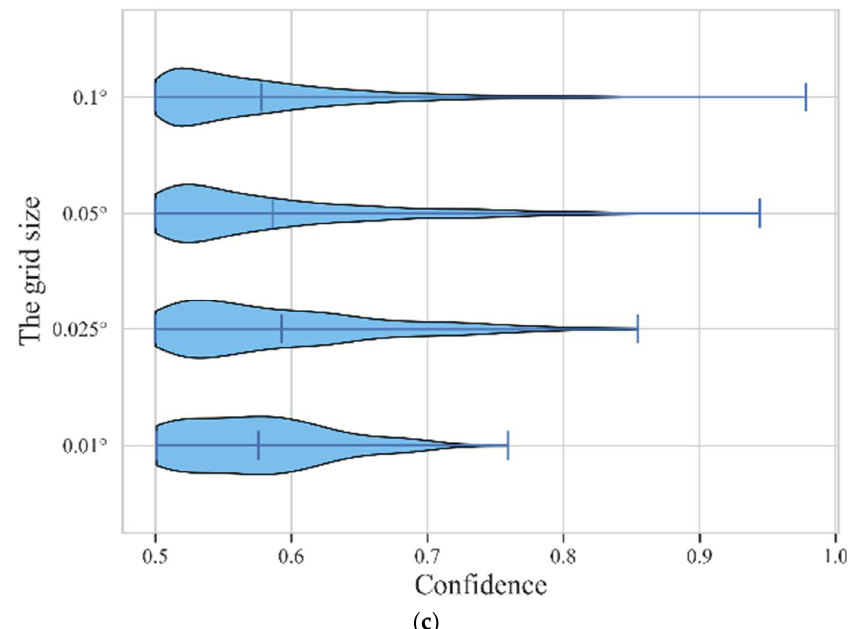
Figure 8. The effect of different grid sizes on confidence. ( a ) Quantity distribution of associated ships in each confidence interval of the result set corresponding to each grid size; ( b ) confidence distribution of the result set corresponding to each grid size; ( c ) confidence distribution of the pattern set corresponding to each grid size. Table 6. Parameters of Figure 8b,c.